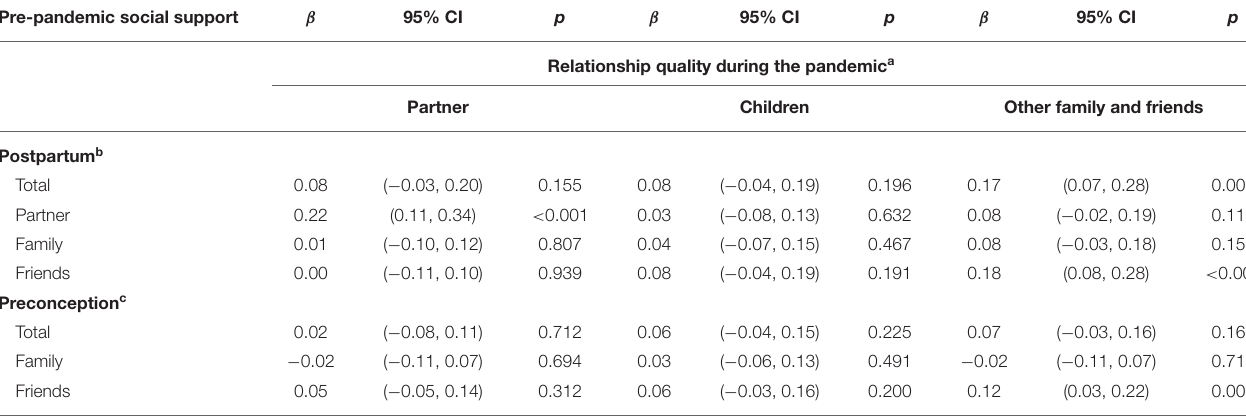
TABLE 2 | Adjusted associations between pre-pandemic social support and relationship quality during the COVID-19 pandemic. Pre-pandemic social support